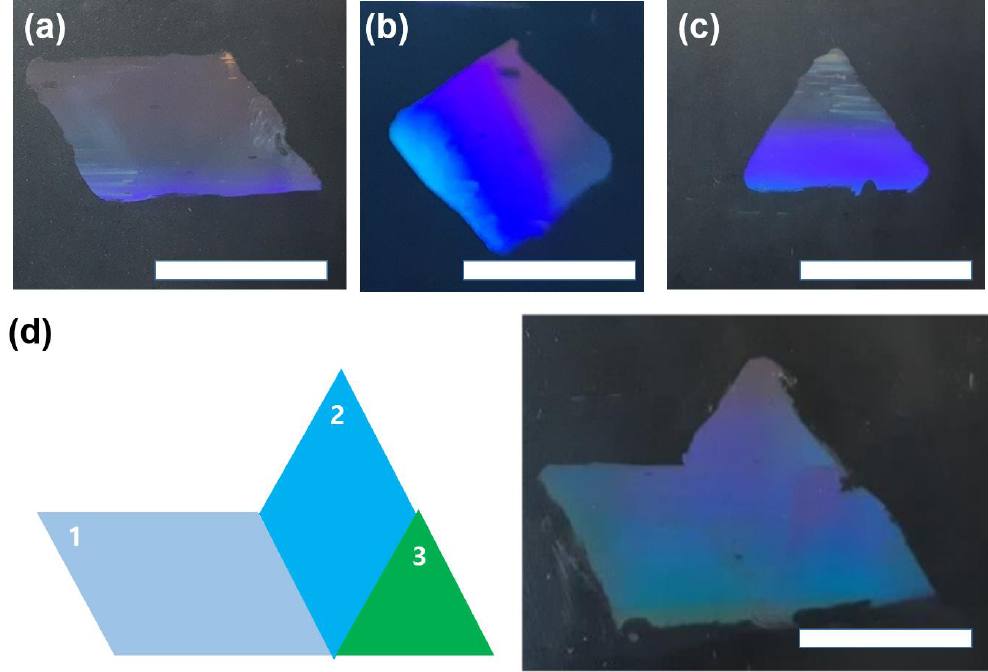
Figure 6. Pictures of the tiles, with the shape of a ( a ) parallelogram, ( b ) diamond, and ( c ) triangle, as well as ( d ) an assembled pattern with the parallelogram, diamond, and triangle-shaped tiles. The scale bars represent 1 cm.